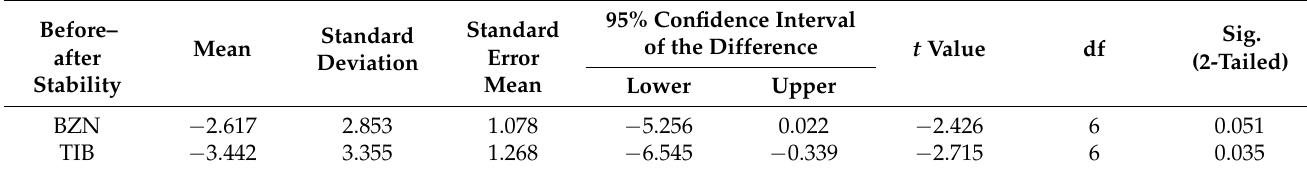
Table 7. Statistical analysis of the formulation F10 exposed to stability